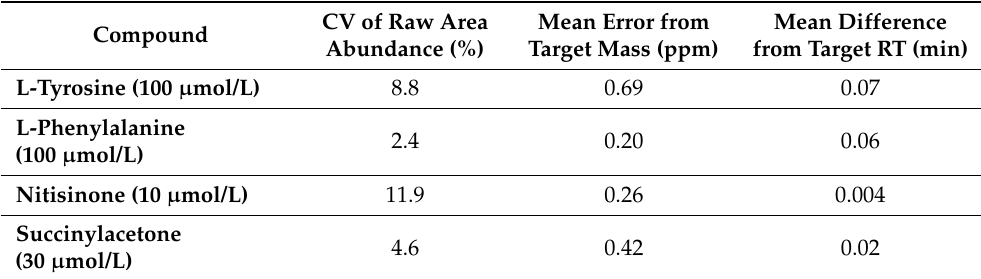
Table 1. Summary of results from the analysis of quality control samples ( n = 8) throughout analytical runs. RT—retention time; CV—coefficient of variation; ppm—parts per million. CV of Raw Area Mean Error from Compound Abundance (%)